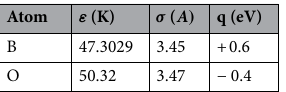
Table 2. Force field parameters for boron